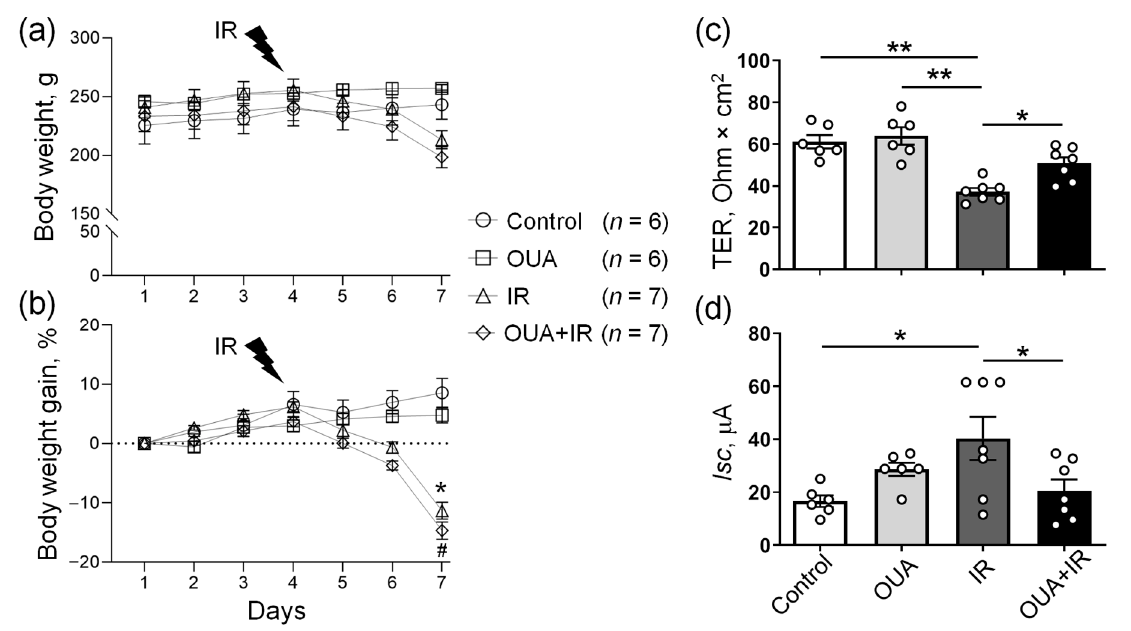
Figure 2. The effects of the chronic administration of exogenous ouabain (OUA), ionizing radiation (IR), and their combination (OUA + IR) on the physiological parameters of rats. ( a , b ) Daily body weight changes during the study in four experimental groups. Rats exposed to IR lost weight, whereas rats that were not exposed to IR gained weight over time. ( c , d ) Changes in the barrier and transport properties of rat colon epithelium were measured in the Ussing chamber. ( c ) Transepithelial electrical resistance (TER). ( d ) Short-circuit current ( Isc ). Measurements were performed after 5 min incubation in the Ussing chamber. For each rat, 3–4 fragments of the colon were examined. The number of rats corresponds to the number of symbols; n = 6 − 7. ( a , b ) * and #, p < 0.05 IR group vs. control group, and OUA + IR group vs. control group, respectively. ( c , d ) * and **, p < 0.05 and 0.01. Two-way ANOVA followed by Bonferroni multiple comparisons test.